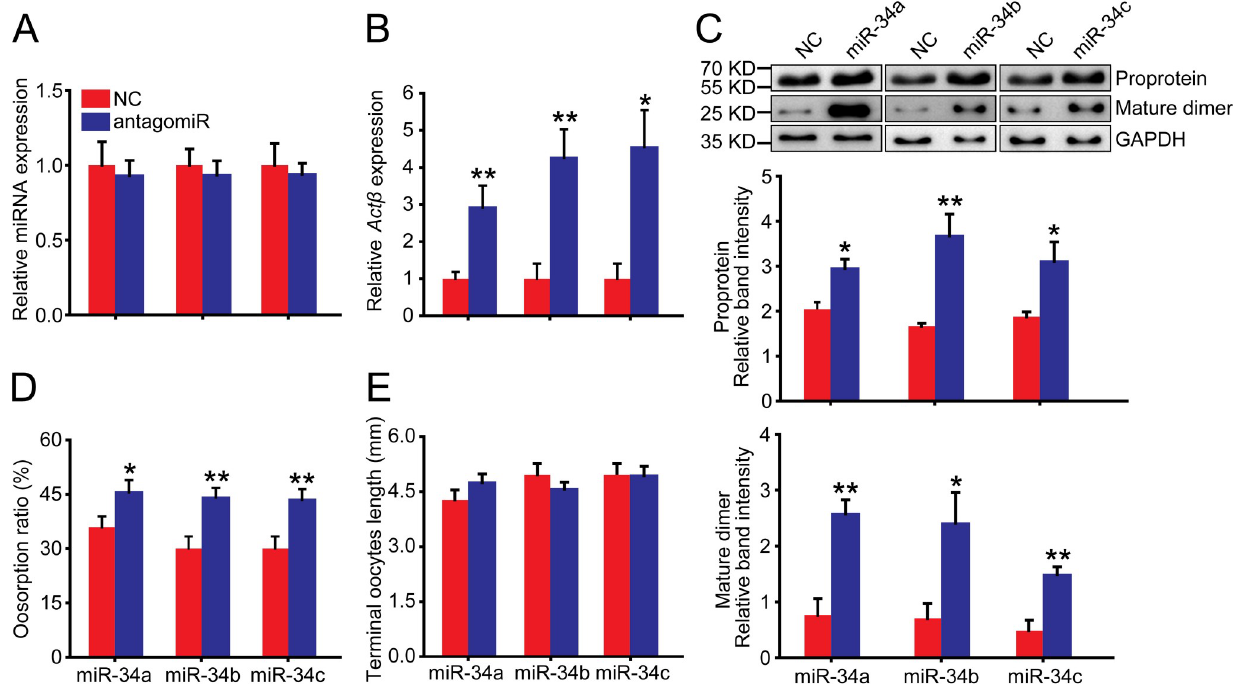
Fig 7. Effects of antagomir-34 injection on oosorption in the solitarious locusts. (A) The relative miRNA abundance of miR-34a, miR-34b or miR-34c in the terminal oocytes after injection with respective antagomirs. n = 7–8. (B) Gene expression level of Act β in the terminal oocytes after injection with antagomir of miR-34a, miR-34b or miR-34c. n = 8–17. (C) Protein expression level of Act β in the terminal oocytes after injection with antagomir of miR- 34a, miR-34b or miR-34c. n = 4. (D) Oosorption ratios after injection with antagomir of miR-34a, miR-34b or miR-34c. n = 17–25. (E) Length of terminal oocytes after injection with antagomir of miR-34a, miR-34b or miR-34c. n = 9–17. � P < 0.05, �� P < 0.01, ��� P < 0.001.